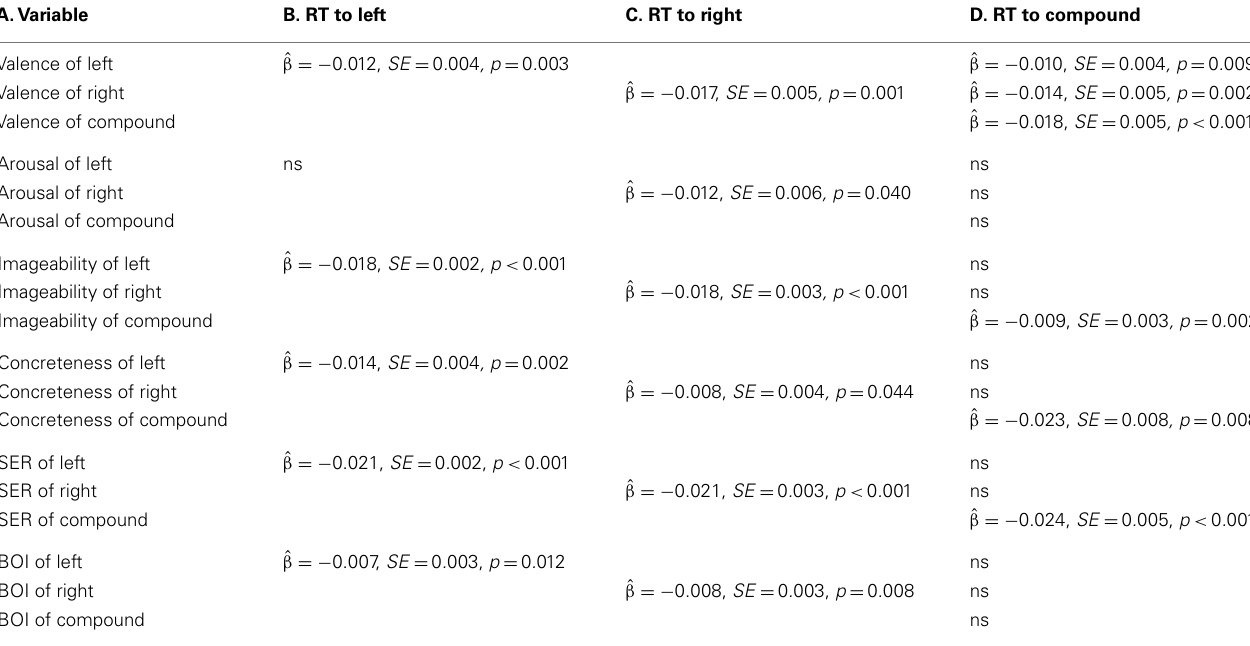
Table 3 | Summary of regression models fitted to lexical decision latencies to compounds’ left constituents presented as isolated words (column B), compound’s right constituents presented as isolated words (column C) and compound words (column D).